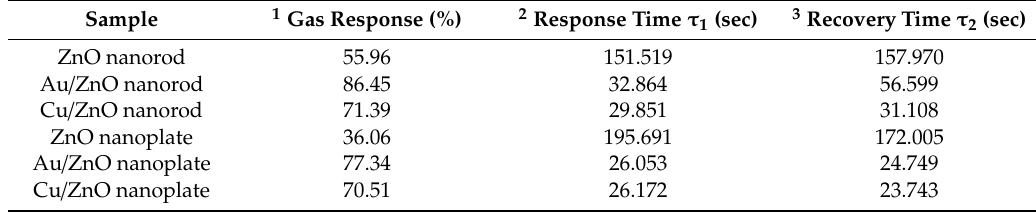
Cu / ZnO Figure 5. The actual response transient of pristine ZnO nanostructures and metal-deposited ZnO nanostructures to 100 ppm CO gas at 200 °C. ( a ) ZnO nanorod and metal-deposited ZnO nanorods. ( b ) ZnO nanoplate and metal-deposited ZnO nanoplates. ( c ) Response and recovery time of pristine ZnO nanostructures and metal-deposited ZnO nanostructures.